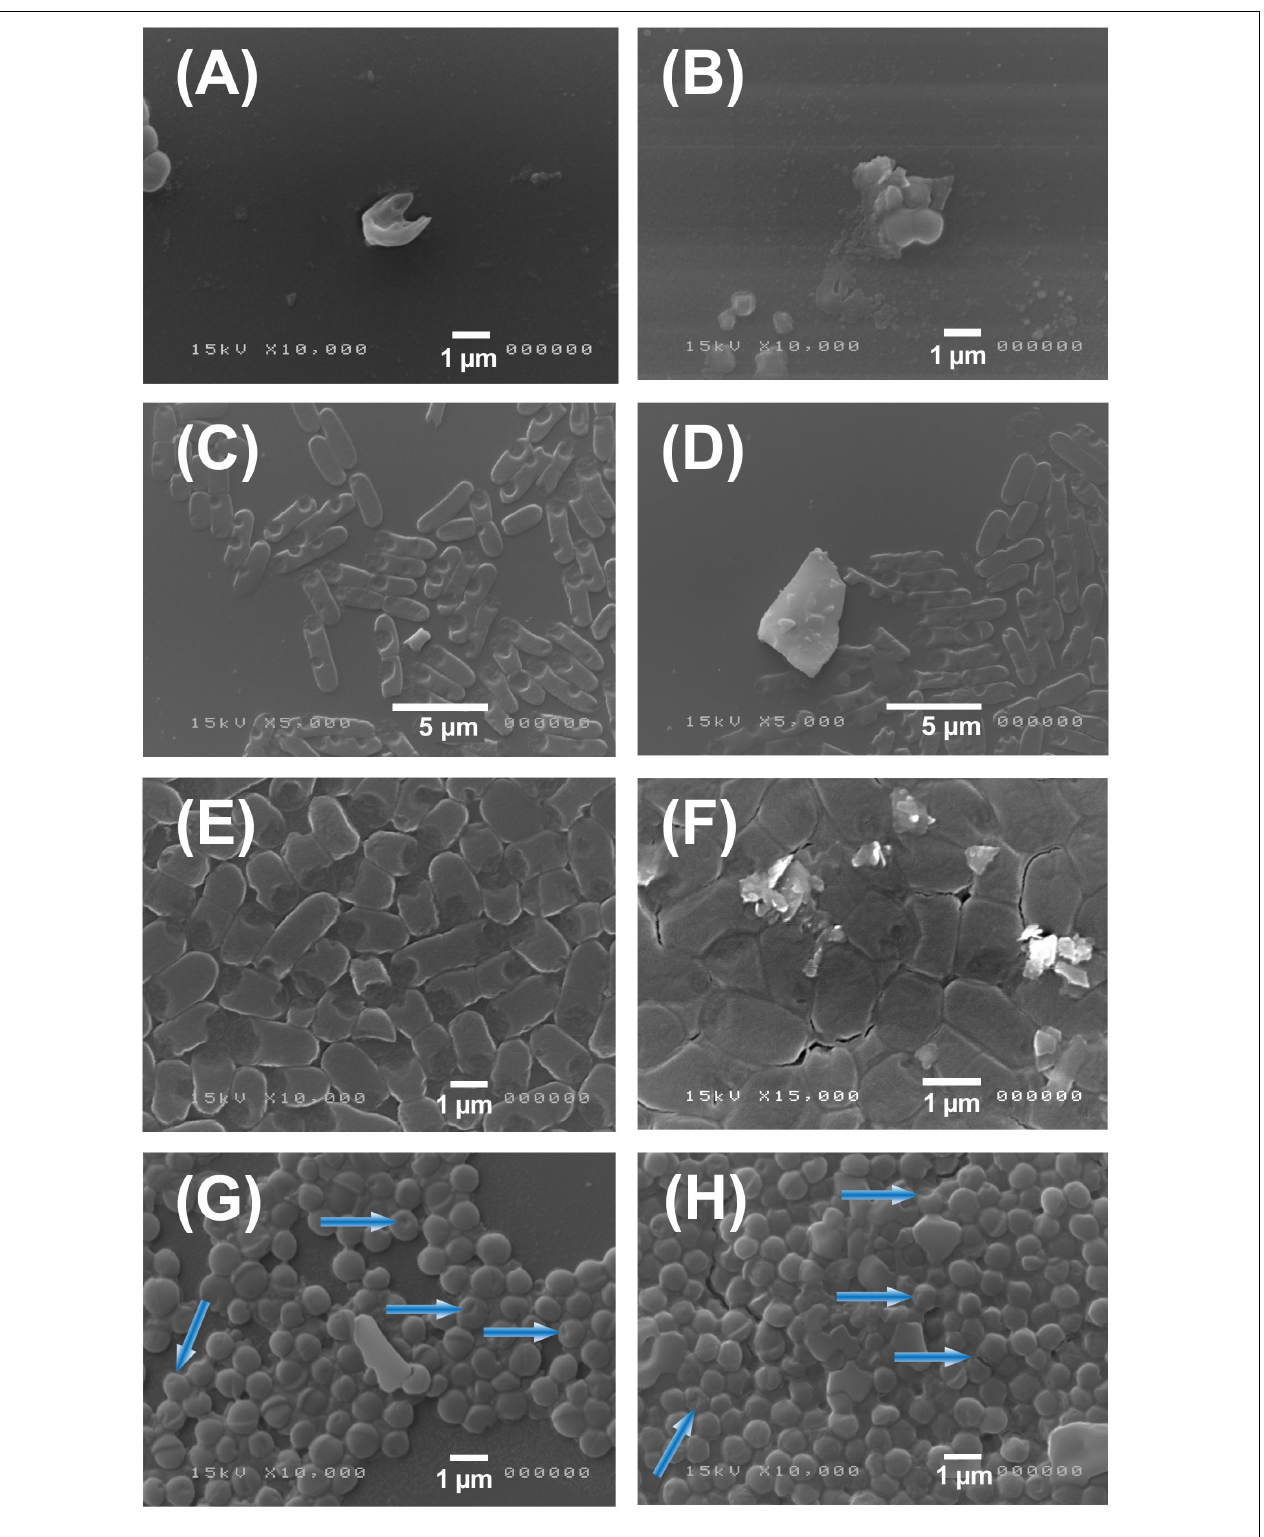
FIGURE 5 | SEM images of S. aureus and E. coli after treatment with MoS 2 NSs. Panel (A–D) : SEM images of S. aureus (A,B) and E. coli (C,D) illustrate the antibacterial effect of MoS 2 NSs after interaction for 3 h. Panel (E–H) : SEM images of E. coli (E,F) and S. aureus (G,H) illustrate the antibacterial effect of MoS 2 NSs after interaction for 6 h and the subsequent damage shown in blue